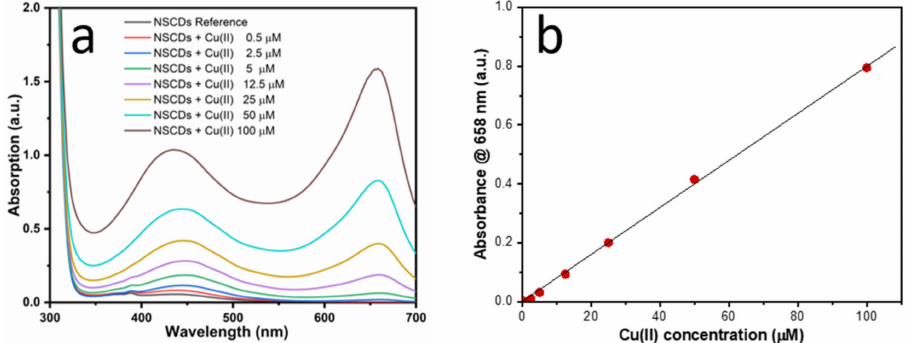
Figure 4. ( a ) UV–Vis absorption spectra of NSCDs-sensing solution upon the addition of Cu(II) ions at different concentrations; ( b ) calibration